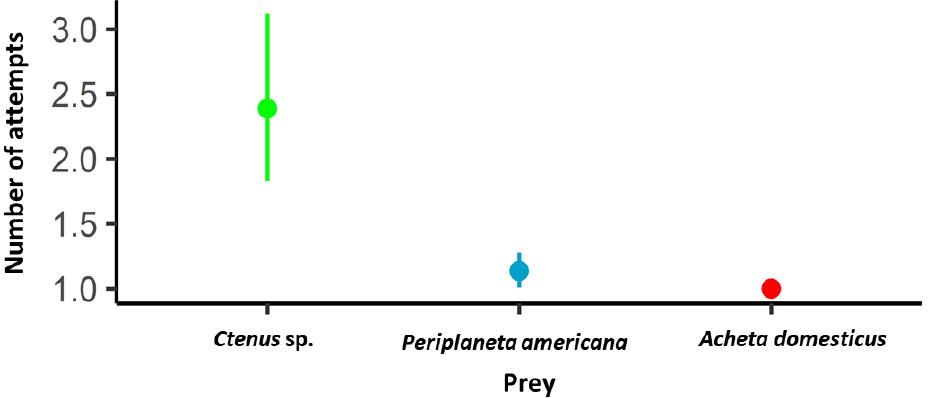
Figure 2. Number of attempts employed by Tityus fuhrmanni when capturing spiders ( Ctenus sp.), crickets ( Acheta domesticus ) and cockroaches ( Periplaneta americana ). Points represent means, lines are 95% confidence intervals. Mean values and confidence intervals were estimated using a generalized estimating equation with a Poisson